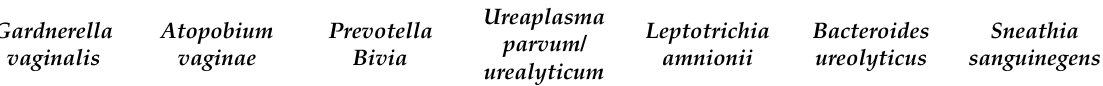
Table 2. Vaginal microbiome composition in HPV positive and HPV negative cervical smears. (The presence of bacteria marked with